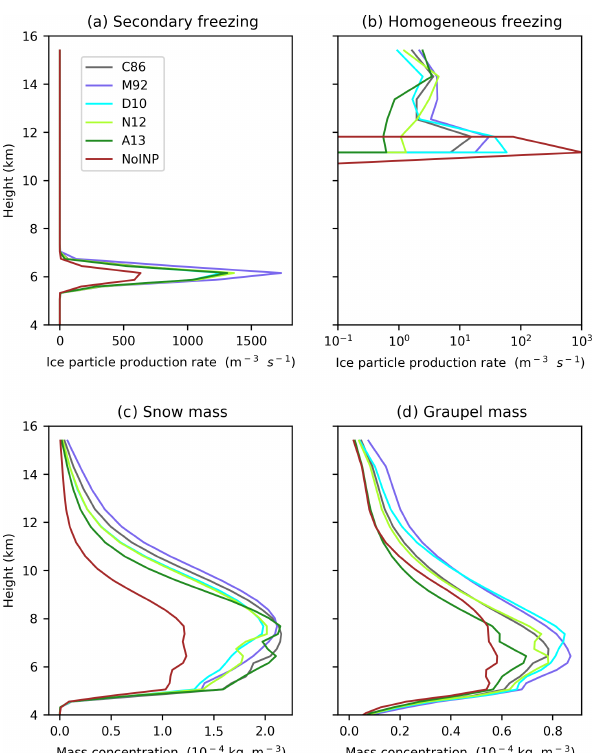
Figure A3. Effect of INPs on domain-mean TOA outgoing daytime (10:00–17:00UTC) shortwave and longwave radiation. The change from the NoINP simulation is shown (INP – NoINP). A positive value indicates more outgoing radiation when INPs are present. The contributions of changes in outgoing radiation from cloudy regions (left; i.e. (cid:49) Rad REFL from Eq. 1) and the cloud fraction (middle; i.e. (cid:49) Rad CF from Eq. 2) to the total radiative forcing (right; i.e. (cid:49) Rad s − r from Eq. 5 with simulation s referring to the simulations with INP active and simulation r referring to the NoINP simulation) are also shown (calculation described in Sect. 2.1.3).